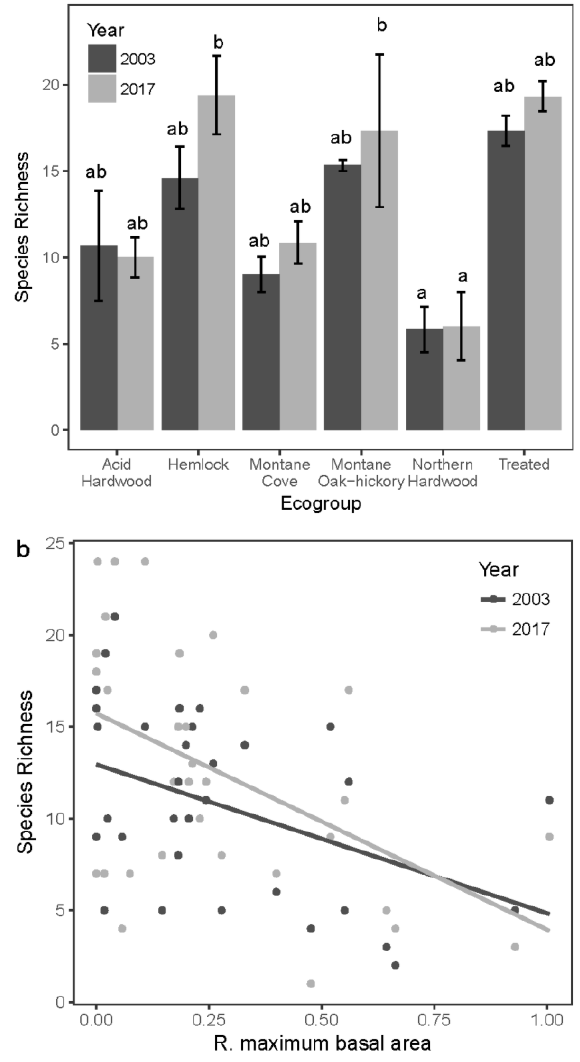
Figure 5. ( a ) Mean (±SE) seedling species richness across ecogroups; ( b ) Seedling species richness as a function of R. maximum basal area. Superscripts indicate significant differences between year and ecogroups (α = 0.05).